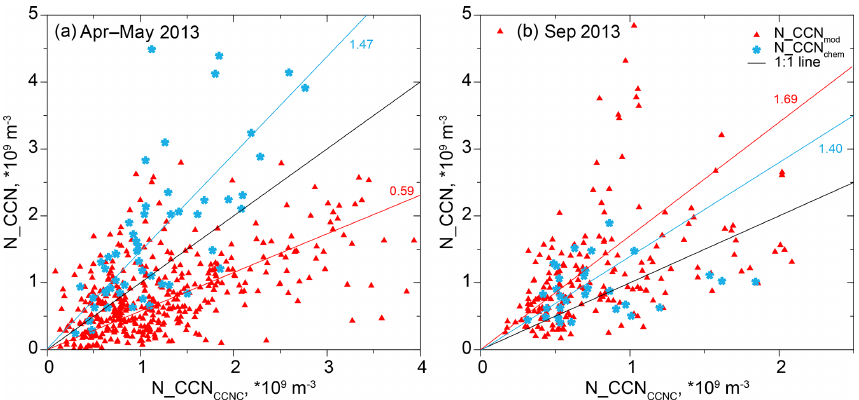
Figure 3. Comparison of derived and measured CCN number concentrations in Melpitz at a supersaturation of 0.2%. Red triangles show results from the aerosol simulations, and blue stars show results from applying the CCN parameterization to the gravimetrically measured aerosol mass concentrations. The colored lines are the linear regressions. The slopes of the fits are given at the regression lines.